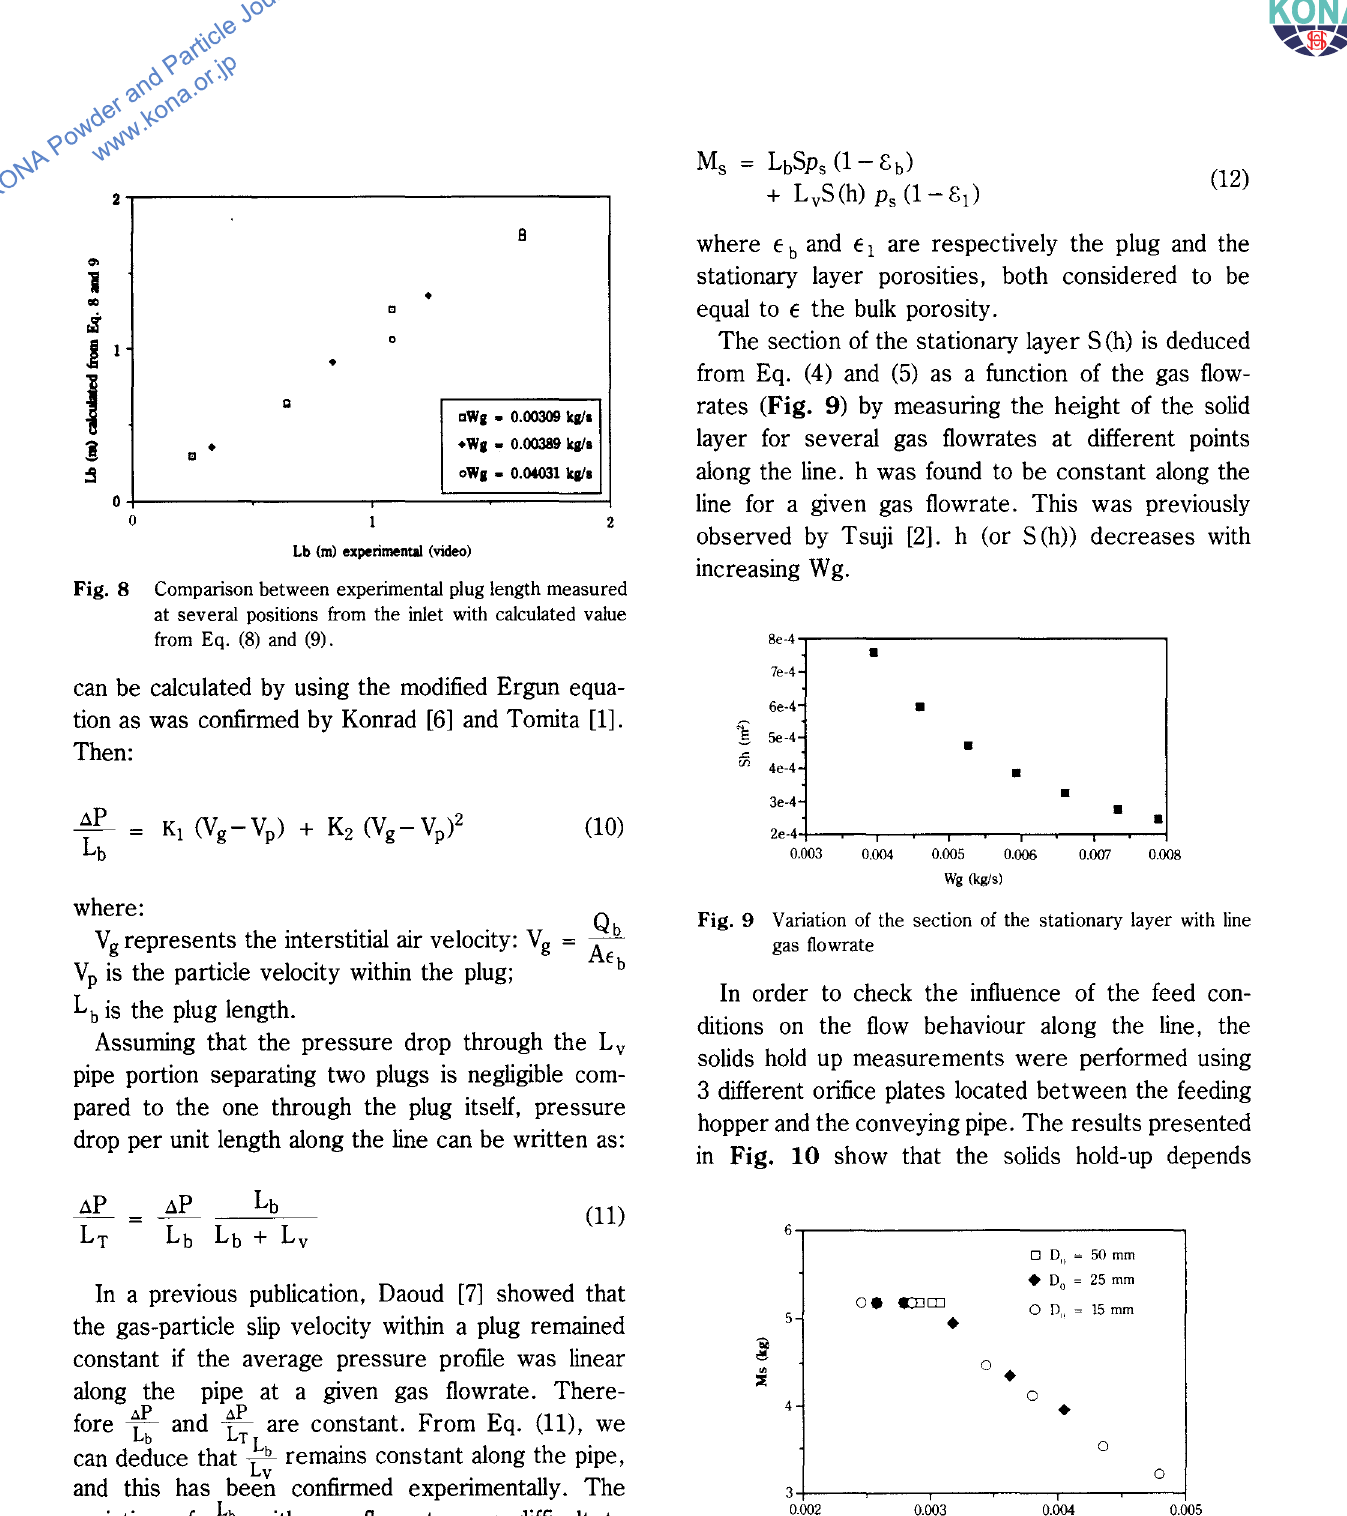
Fig. 10 Variation of solids hold up between the two pneumatic valves 10 m apart with inlet gas flowrate for several orifice plate diameters only on the volumetric gas flowrate at the entrance of the pipe, no matter what the orifice plate diameter is at the entrance of the pipe. On the other hand, the solids flowrate is strongly dependent on the orifice plate diameter as presented in Fig. 11.